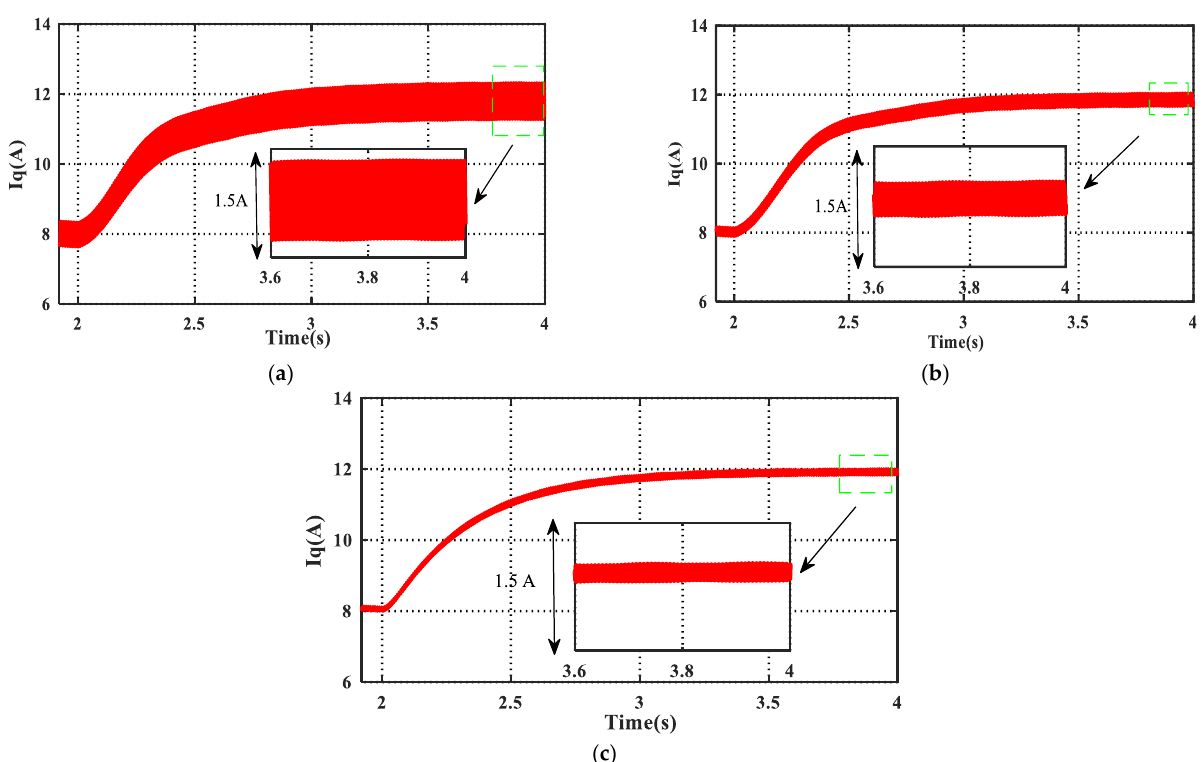
Figure 13. Simulation results of q -axis current during the load operation: ( a ) with a PI controller, ( b ) with a PIR controller and ( c ) with a Robust-TDOFR controller. Table 4. Simulation results under the operation of load.